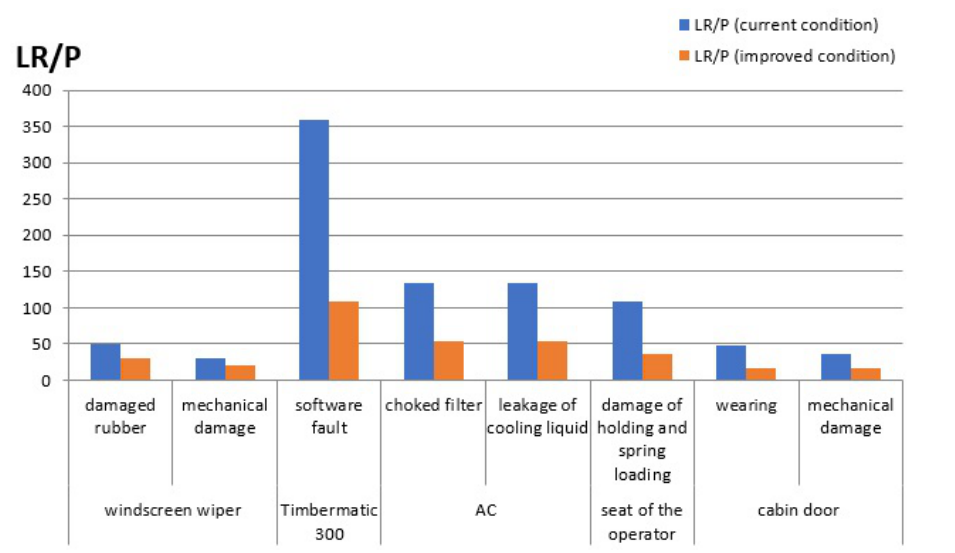
Figure 8: FMEA results for cabin and controlling devices of harvester John Deere 1070D